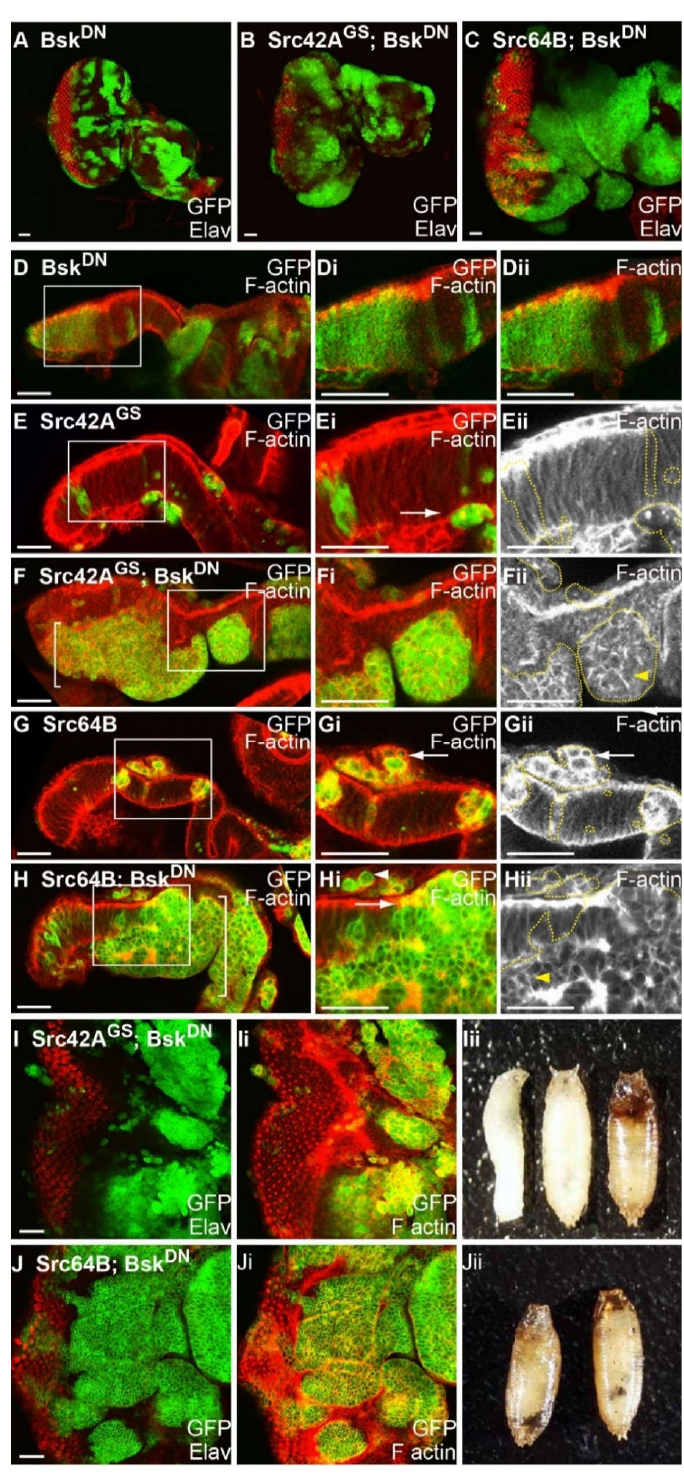
Figure 6. Blocking JNK results in increased clone viability and basally localised clonal tissue. Confocal images, planar views or cross-sections, of eye-antennal discs: Clones are marked by GFP (green in merged images). Elav marks differentiated cells (red in merged images A – C , I , J ) and rhodamine-phalloidin visualises F-actin to mark cell outlines (in D – H as marked, red in merged images, ii ; red in merged images, Ii , Ji ). Light micrographs Iii , Jii . ( A – D ) Planar views ( E – H )